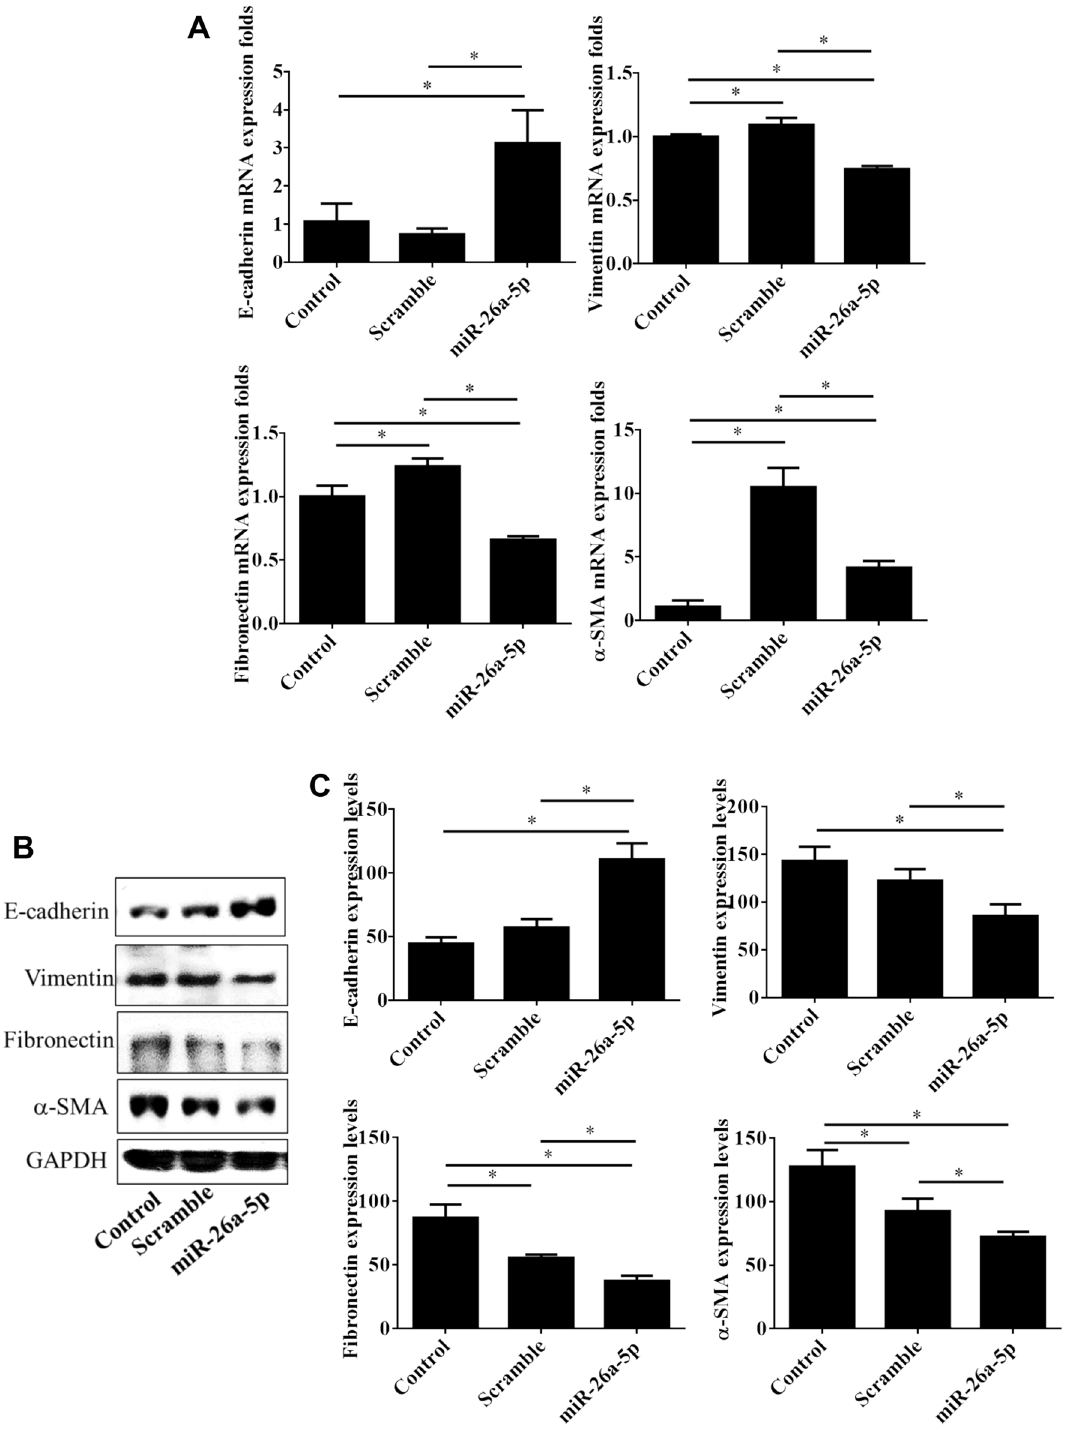
Figure 4. miR-26a-5p overexpression inhibited expression of epithelial-to-mesenchymal transition markers in UTUC cells. BFTC-909 UTUC cells were transfected with miR-26a-5p mimics for 48 h and subjected to mRNA and protein measurements. Expression levels of epithelial marker E-cadherin and mesenchymal markers including vimentin, fibronectin, and α-SMA were assayed with qPCR ( A ) and western blot ( B ), respectively. GAPDH was used as loading internal control. ( C ) The blotting densitometry of protein levels in BFTC-909 cells. Data are expressed as mean ± SEM (n = 3). *Indicates a P < 0.05 between the indicated